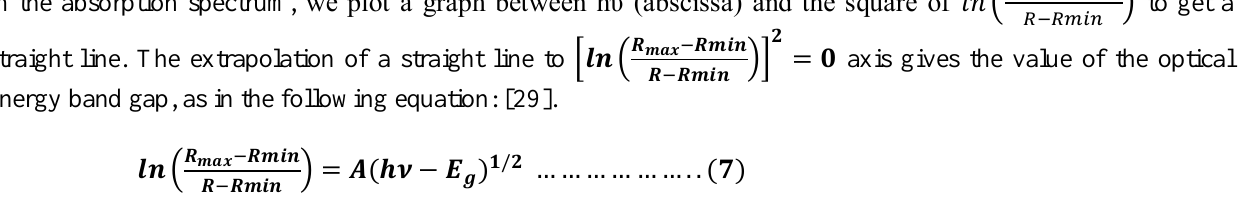
NRs on FTO substrate by the hydrothermal method at 180̊ °C for 2